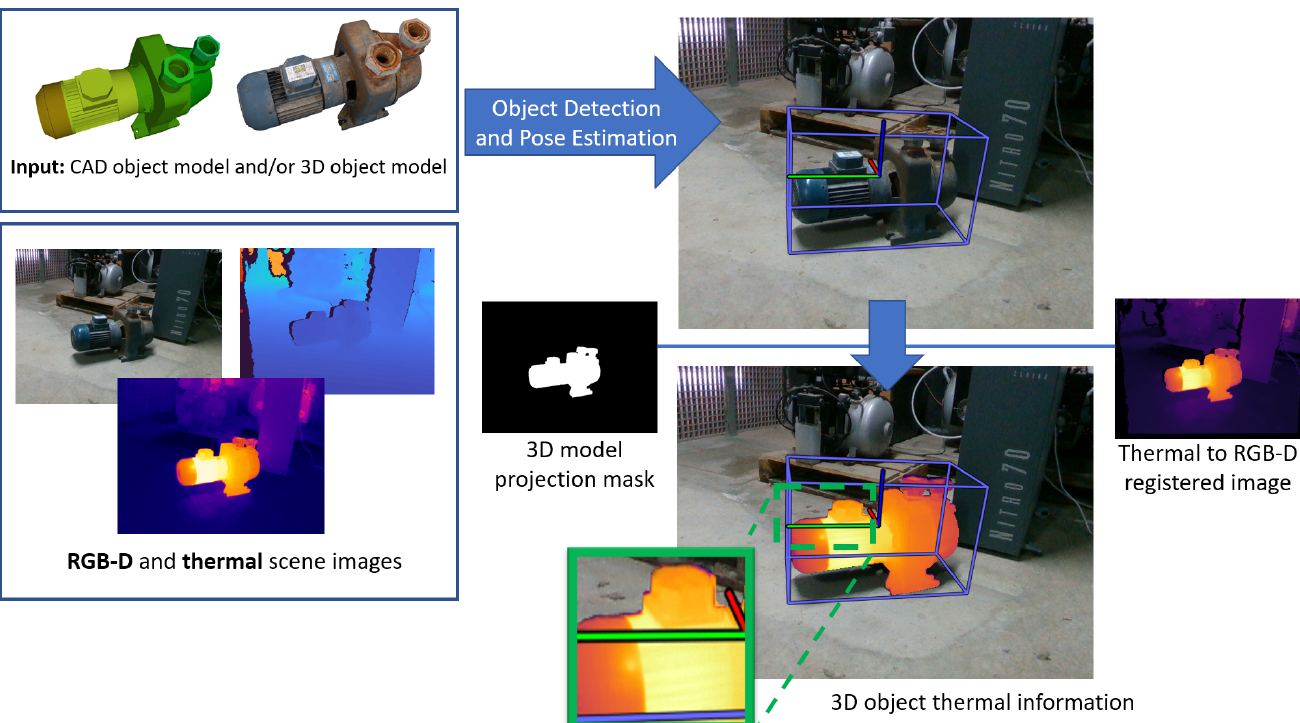
Figure 1. Process diagram of the object detection and pose estimation for combining IRT